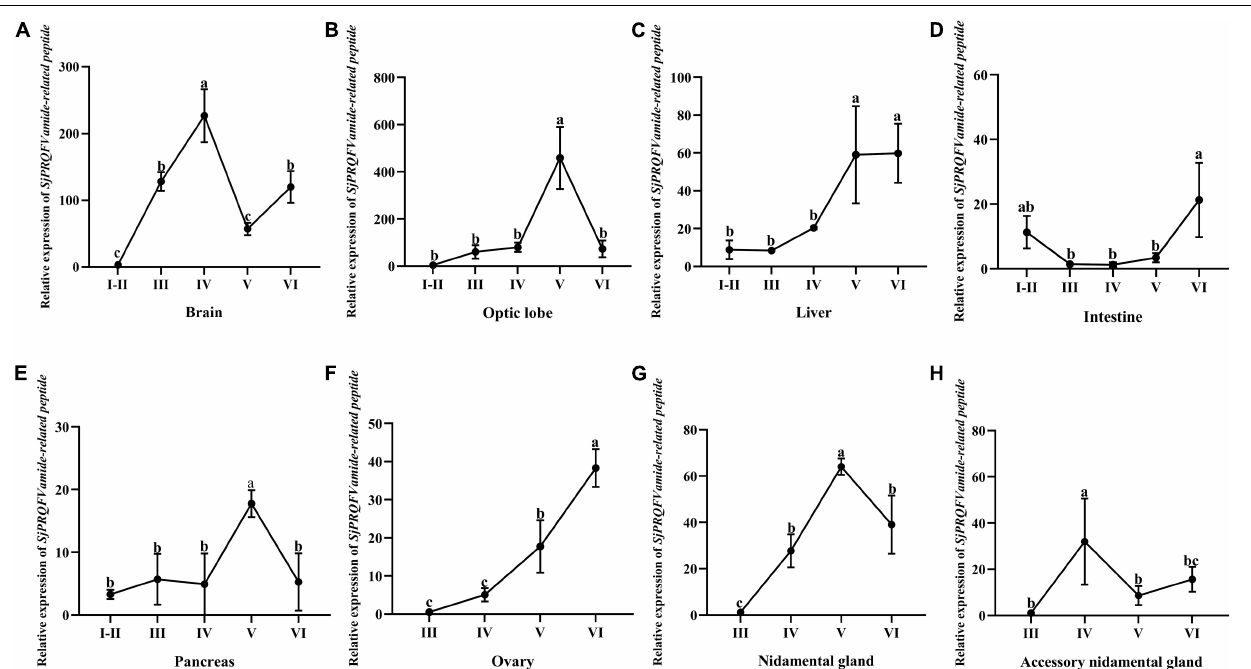
FIGURE 5 | The expression level of SjPRQFVRP of females in different tissues at different stages. Vertical bars represent the mean ± SD ( n = 3). GAPDH and β -actin served as reference genes. Different letters indicate statistically significant differences ( p < 0.05). (A) Expression trend of SjPRQFVRP in the brain. (B) Expression trend of SjPRQFVRP in the optic lobe. (C) Expression trend of SjPRQFVRP in the liver. (D) Expression trend of SjPRQFVRP in the intestine. (E) Expression trend of SjPRQFVRP in the pancreas. (F) Expression trend of SjPRQFVRP in the ovary. (G) Expression trend of SjPRQFVRP in the nidamental gland. (H) Expression trend of SjPRQFVRP in the accessory nidamental